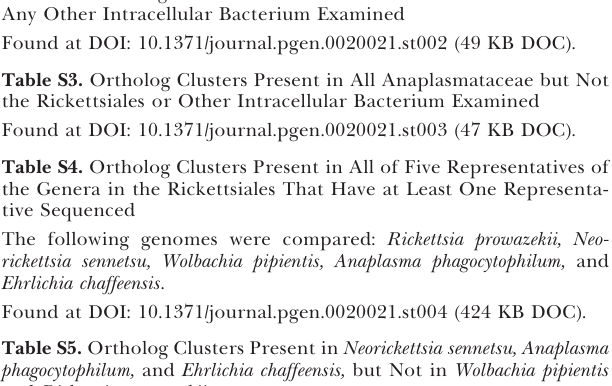
Repeats are shown by dual-arrowed line segments; paralogs are represented by arrows. Figure S2. Phylogenetic Tree of OMP1 Proteins The protein sequences of all the members of PFAM01617 were aligned and a phylogenetic tree inferred. The divergence of the OMP1/MSP2/P44 proteins in this superfamily did not permit robust inferences about the evolution of these proteins, but allowed classification of the proteins into superfamilies as reflected in their annotation. Particular families within this superfamily are high- lighted, including the P44 proteins (pink), the OMP-1s (blue), and the Wsp (yellow). Found at DOI: 10.1371/journal.pgen.0020021.sg002 (876 KB PDF). Figure S3. Distribution of the p44 Genes in A. phagocytophilum Strains Rims 1 and 2: predicted coding regions on the plus and minus strands, respectively, color-coded by role categories. Rim 3: atypical nucleotide composition. Rim 4: distribution of p44 silent genes (green), expression locus (cyan), full-length genes (magenta), frag- ments (brown), and truncations (blue). Rims 5 and 6: microarray- based comparative genome hybridization results for A. phagocytophi- lum strain HZ against strains MRK and MN. The ratios [(HZ normalized intensity)/(query normalized intensity)] were divided into three categories: ratio . 10 (red; absent); ratio 3–10 (blue; absent/ divergent); and ratio , 3 (not plotted; present). Found at DOI: 10.1371/journal.pgen.0020021.sg003 (1.0 MB PDF). Figure S4. Type IV Secretion Systems in Rickettsiales Genes encoding the type IV secretion system components can be found at two distinct regions of the Rickettsiales genome. At the larger of these regions, virB3, virB4, and virB6 show a typical arrangement. These are followed by a series of genes in the virB6 family that have been shown to be cotranscribed in W. pipientis w Mel. Each of these regions is presented with ortholog clusters (see Materials and Methods) and color coded: cyan, virB3; orange, virB4; green, virB6; and purple, a virB6 family of genes. Orthologs conserved in location are connected with gray bars. The virB3 gene is not always annotated, due to its small size, but it is present in all Rickettsiales genomes examined. Figure S5. Transcript Analysis of Biotin Biosynthetic Genes DNase-treated total RNA was reverse-transcribed and subsequently PCR amplified using primers specific to each biotin biosynthesis gene. RT-PCR analysis showed that all four genes in the biotin biosynthesis pathway (BioA/B/D/F) were expressed by E. chaffeensis and A. phagocytophilum in THP-1 and HL-60 cells, respectively, at 2 d (unpublished data) and 3 d postinfection. Found at DOI: 10.1371/journal.pgen.0020021.sg005 (61 KB JPG). Table S1. Ortholog Clusters Conserved across All Representative Obligate and Facultative Intracellular Pathogens and Endosymbionts Presented in a Tab-Delimited Format Table S2. Ortholog Clusters Present in All the Rickettsiales but Not in Any Other Intracellular Bacterium Examined Table S3. Ortholog Clusters Present in All Anaplasmataceae but Not the Rickettsiales or Other Intracellular Bacterium Examined Found at DOI: 10.1371/journal.pgen.0020021.st003 (47 KB DOC). Table S4. Ortholog Clusters Present in All of Five Representatives of the Genera in the Rickettsiales That Have at Least One Representa- tive Sequenced The following genomes were compared: Rickettsia prowazekii, Neo- rickettsia sennetsu, Wolbachia pipientis, Anaplasma phagocytophilum, and Ehrlichia chaffeensis . Table S5. Ortholog Clusters Present in Neorickettsia sennetsu, Anaplasma phagocytophilum, and Ehrlichia chaffeensis, but Not in Wolbachia pipientis and Rickettsia prowazekii